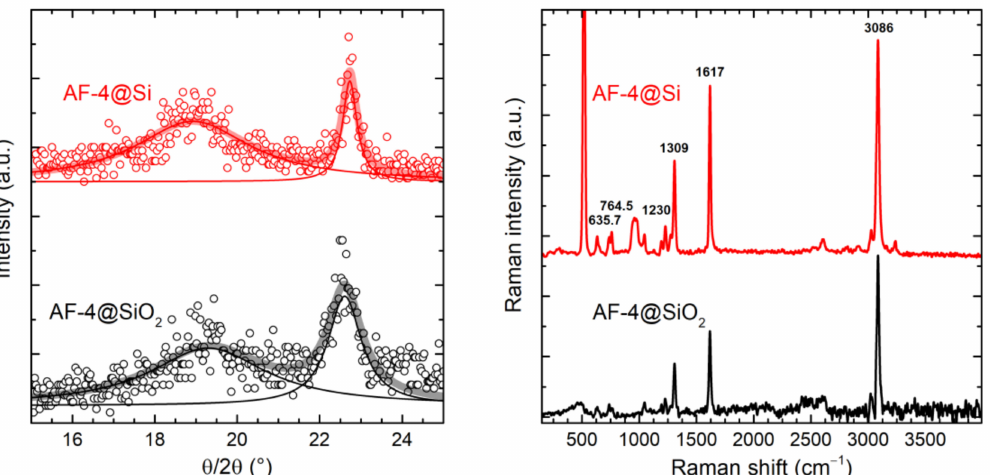
Figure 5. ( Left ) X-ray diffraction patterns and ( right ) Raman spectra of the 1.6 µ m parylene AF4 films deposited on the Si and SiO 2